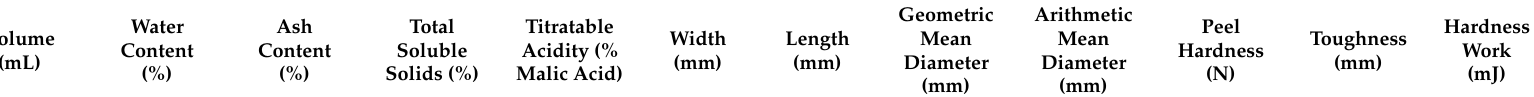
Table 6. Pearson correlations between physico-chemical and textural attributes of the 22 studied apple